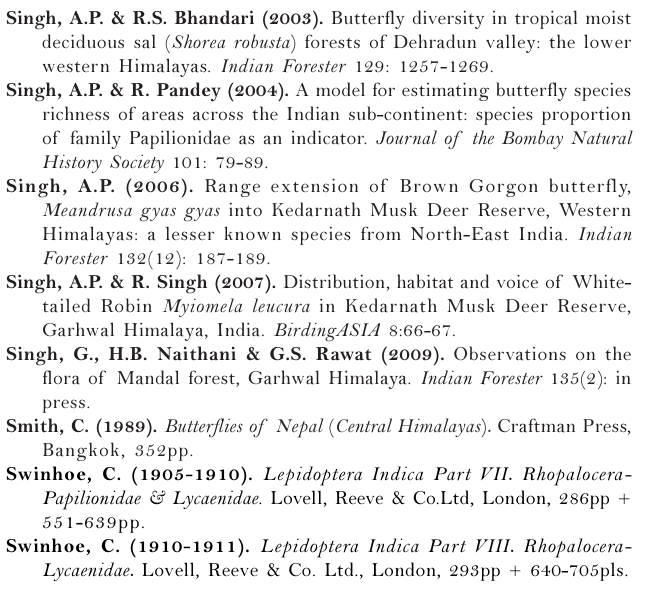
Image 142. Large Hedge Blue, Celasrina huegelii